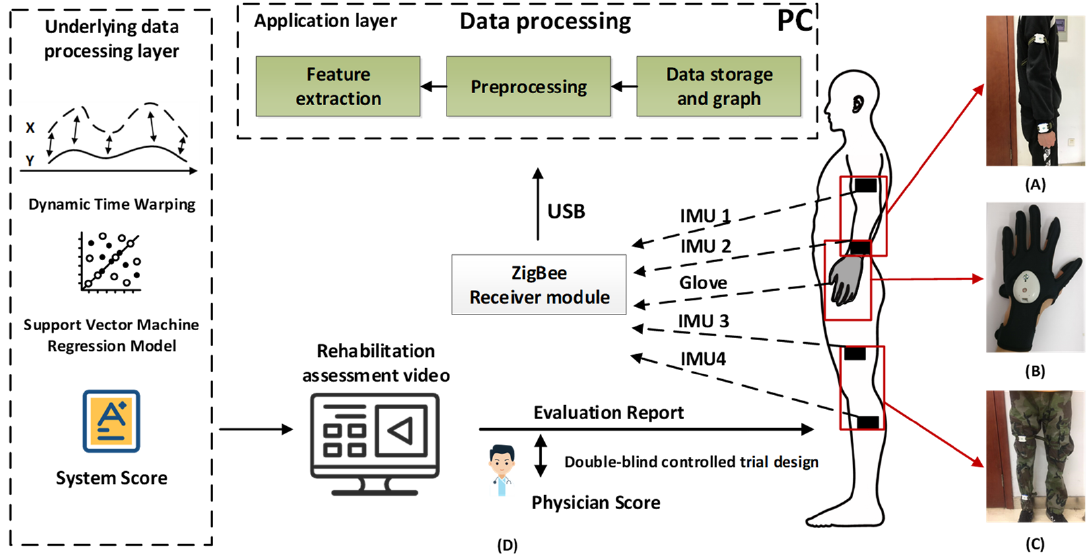
Figure 1. Rehabilitation assessment process based on wearable devices and machine learning. Upper limb-wearing instructions ( A ), glove-wearing instructions ( B ), and lower limb-wearing instructions ( C ) are the schematic diagrams of upper limbs, hands, and lower limbs with wearable devices on the affected side, respectively. Rehabilitation assessment process ( D ) is the schematic diagram of the rehabilitation assessment process.